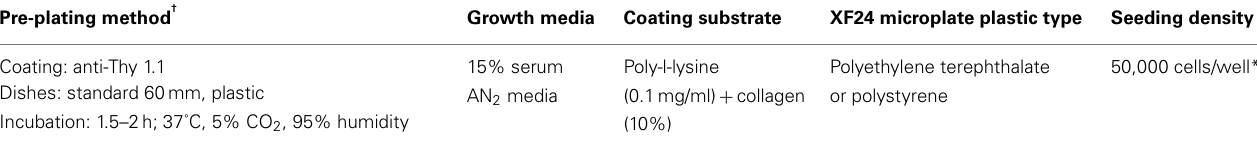
FIGURE 2 | Optimization of coating substrates for DRG neuronal culture. (A) 24-well Seahorse XF24 microplates coated with collagen promoted aggregation and clumping of DRG neurons (yellow asterisks). (B) Poly-lysine, poly-ornithine, and the optimal substrate combination of poly-lysine + 10% collagen provided equally satisfactory DRG neuron